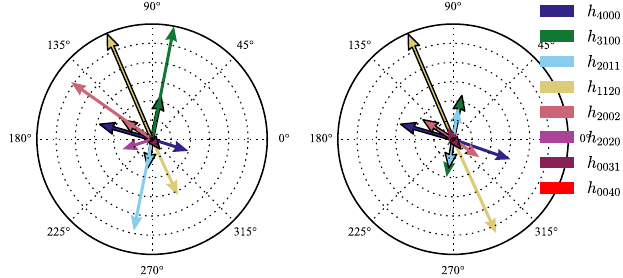
FIG. 5. Vector representation of the 8 fourth-order on-momen- tum RDTs, calculated from Eqs. (A5), (A6), (A7), (A8), (A9), (A10), (A11), and (A12), generated to second order by the sextupole cross talks (black contoured arrows) and to the first order by the octupoles when powered to fully cancel the linear ADTS. The left plot shows the case of the unphased octupole triplet oct . The right plot shows the case of the optimal octupoles H location, where all fourth RDTs are simultaneously corrected by the oct triplet. C